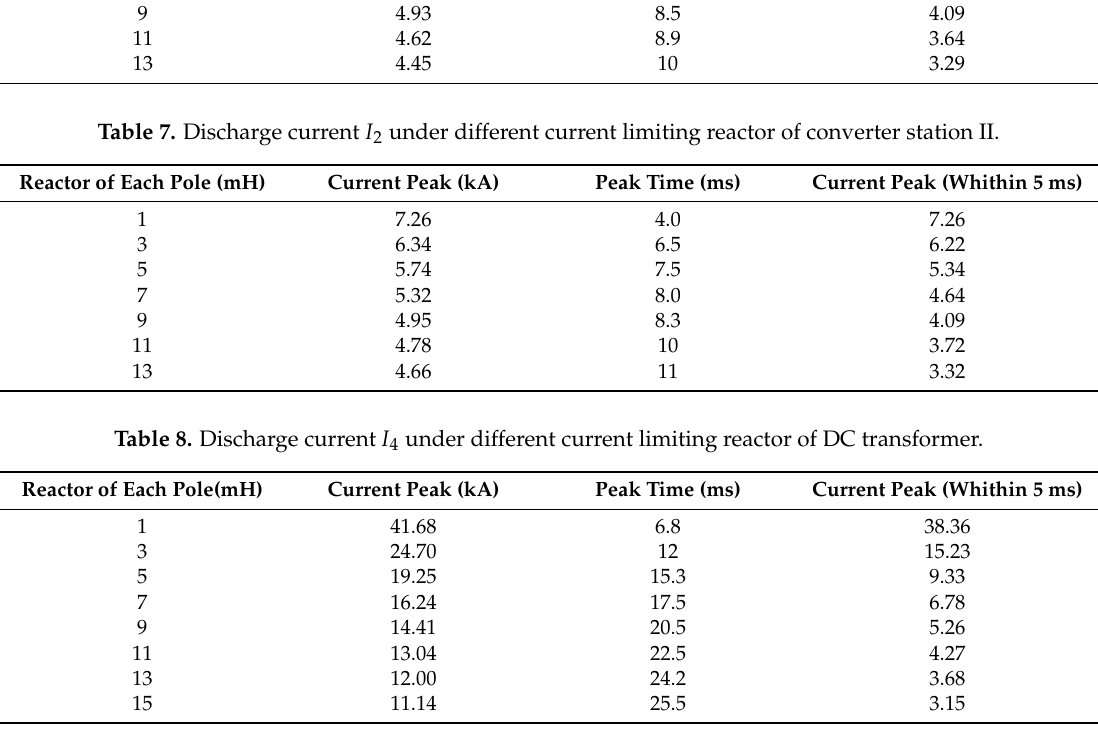
Table 6. Discharge current I 1 under different current limiting reactor of converter station I. Reactor of Each Pole (mH)